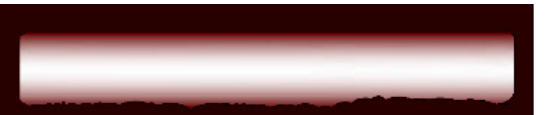
Figure 5. Close contact melting process in a rectangular cavity adapted from the study of Hirata et al. [65].